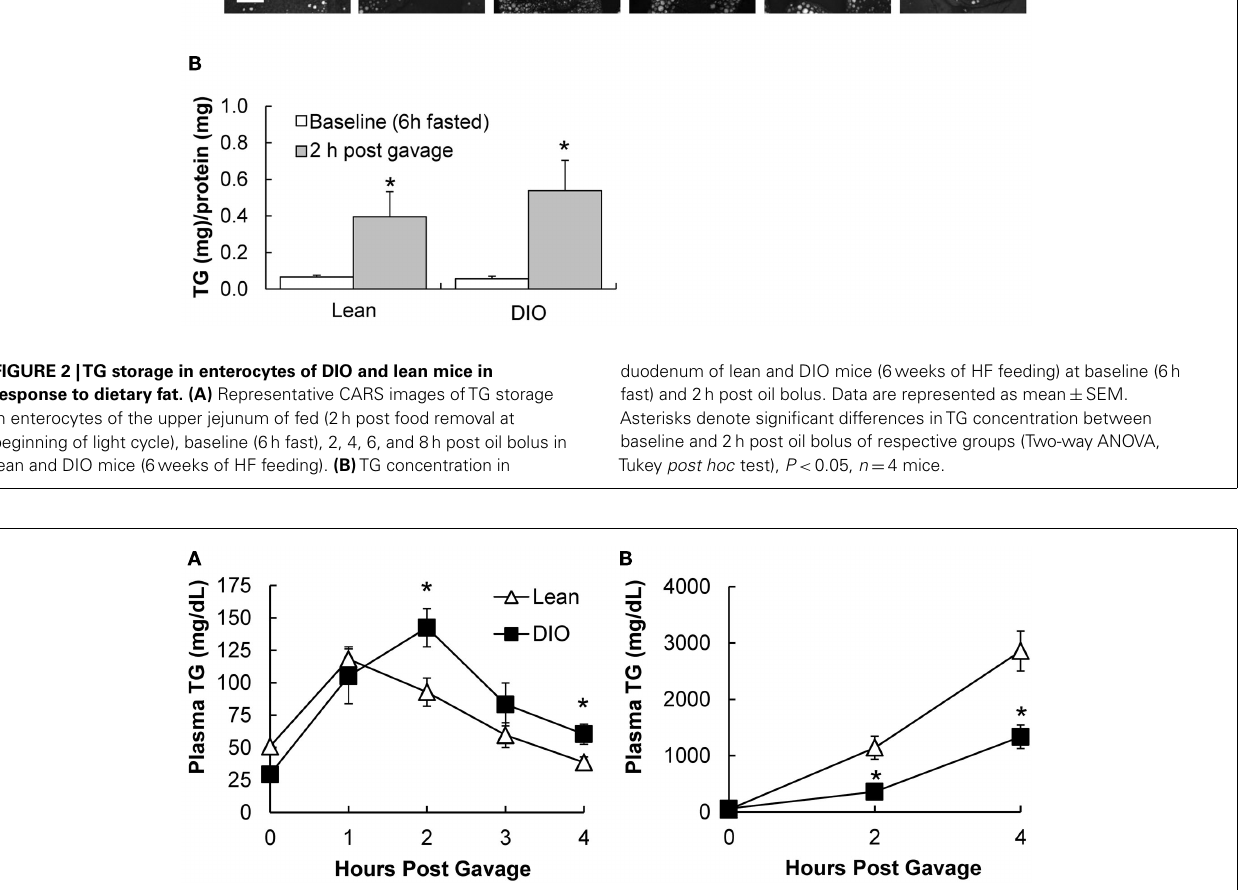
(B) Mice were fasted for 4h at the beginning of the light cycle and injected with 500mg/kgTyloxapol into the intraperitoneal cavity to block lipase activity in circulation. After 30min, mice were administered 200 μ l olive oil via oral gavage and plasmaTG measured before and 2 and 4h post oil bolus. Data are represented as mean ± SEM. Asterisks denote significant differences at time points compared to lean mice ( T -test), P < 0.05, n = 5